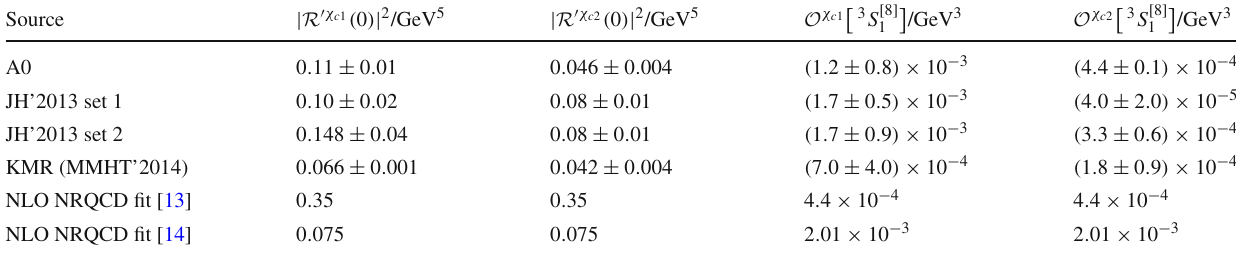
Table 2 The fitted values of LDMEs and CS wave functions at the origin for χ cJ mesons (divided by the 2 J + 1 factor). All LDMEs are considered independent (“fit II” scenario). The results obtained in the NLO NRQCD fits [13,14] are shown for